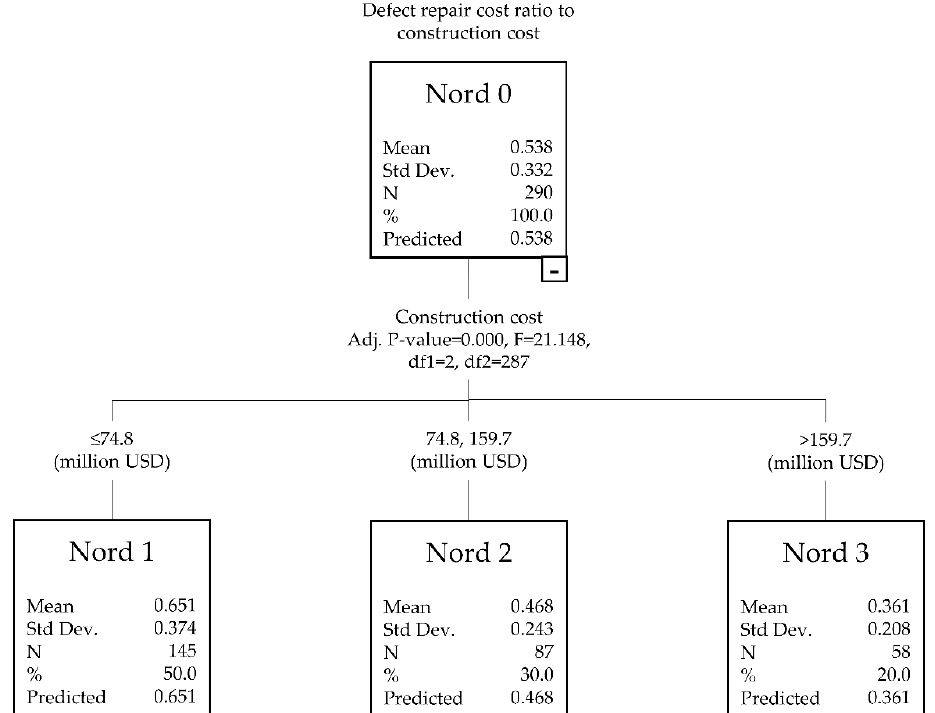
Table 3. Statistics of Plan C and Plan D.